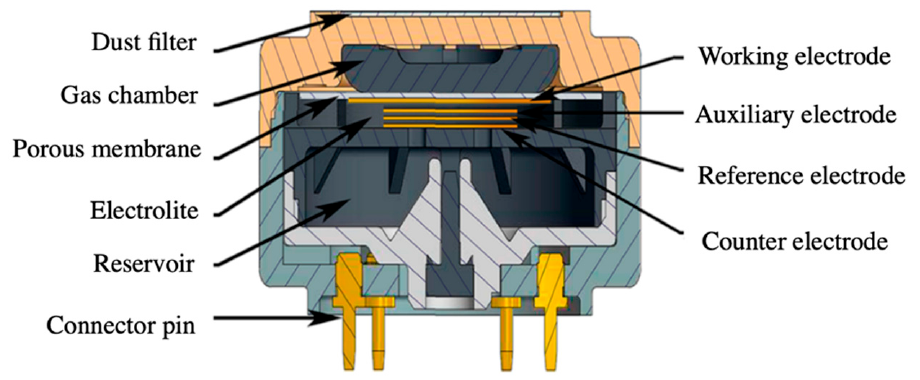
Figure 4. Schematic design of a standard amperometric gas sensor. Reprinted with permission from ref [84]. Copyright 2017, American Chemical Society (ACS).